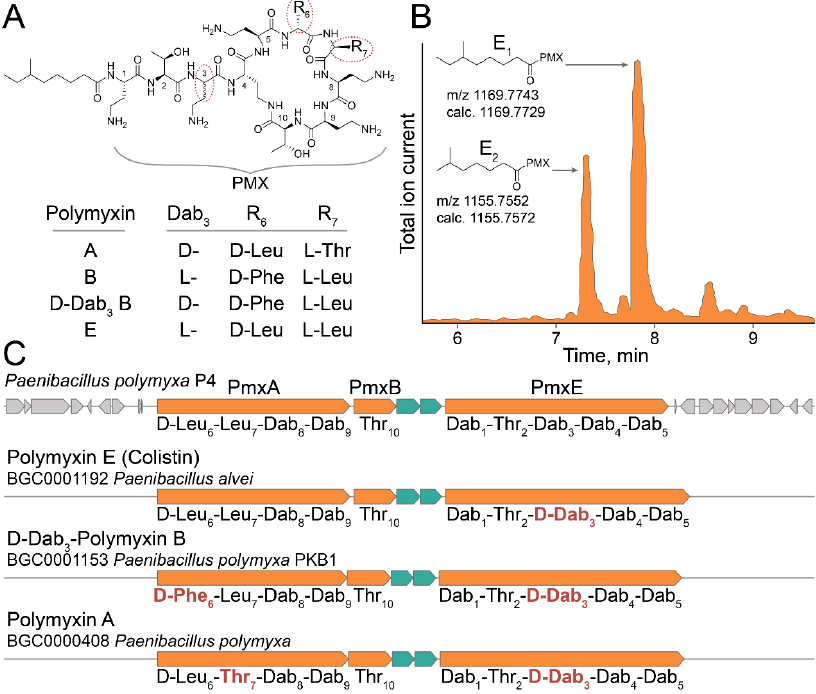
Figure 6. Multi-omic characterization of Paenibacillus polymyxa P4 strain selected by ultrahigh- throughput screening of anti-Gram-negative antibiotic activity using the developed live biosensor. ( A ) Polymyxin E (colistin) was identified as a major secondary metabolite of P. polymyxa P4 active against Gram-negative bacteria. The chemical structures of polymyxin E and related polymyxins A, B, and D-Dab 3 B produced by distinct Paenibacillus are presented. PMX—colistin peptide backbone. ( B ) LC-MS chromatogram of active fraction of P. polymyxa P4 metabolites. Specific peaks of polymyxin E 1 and polymyxin E 2 are presented with their experimental and calculated [M+H] + molecular ion masses. ( C ) BGC of polymyxin E identified in the genome of P. polymyxa P4. Core NRPSs (PmxA, PmxB, and PmxE) and ABC transporters are colored with orange and aquamarine, respectively. Predicted amino acid specificity of NRPS modules are presented. Related BGCs of polymyxin A [21], D-Dab 3 -polymyxin B [22], and polymyxin E [23] are presented with their predicted modular specificities. Distinct modular specificities are highlighted with